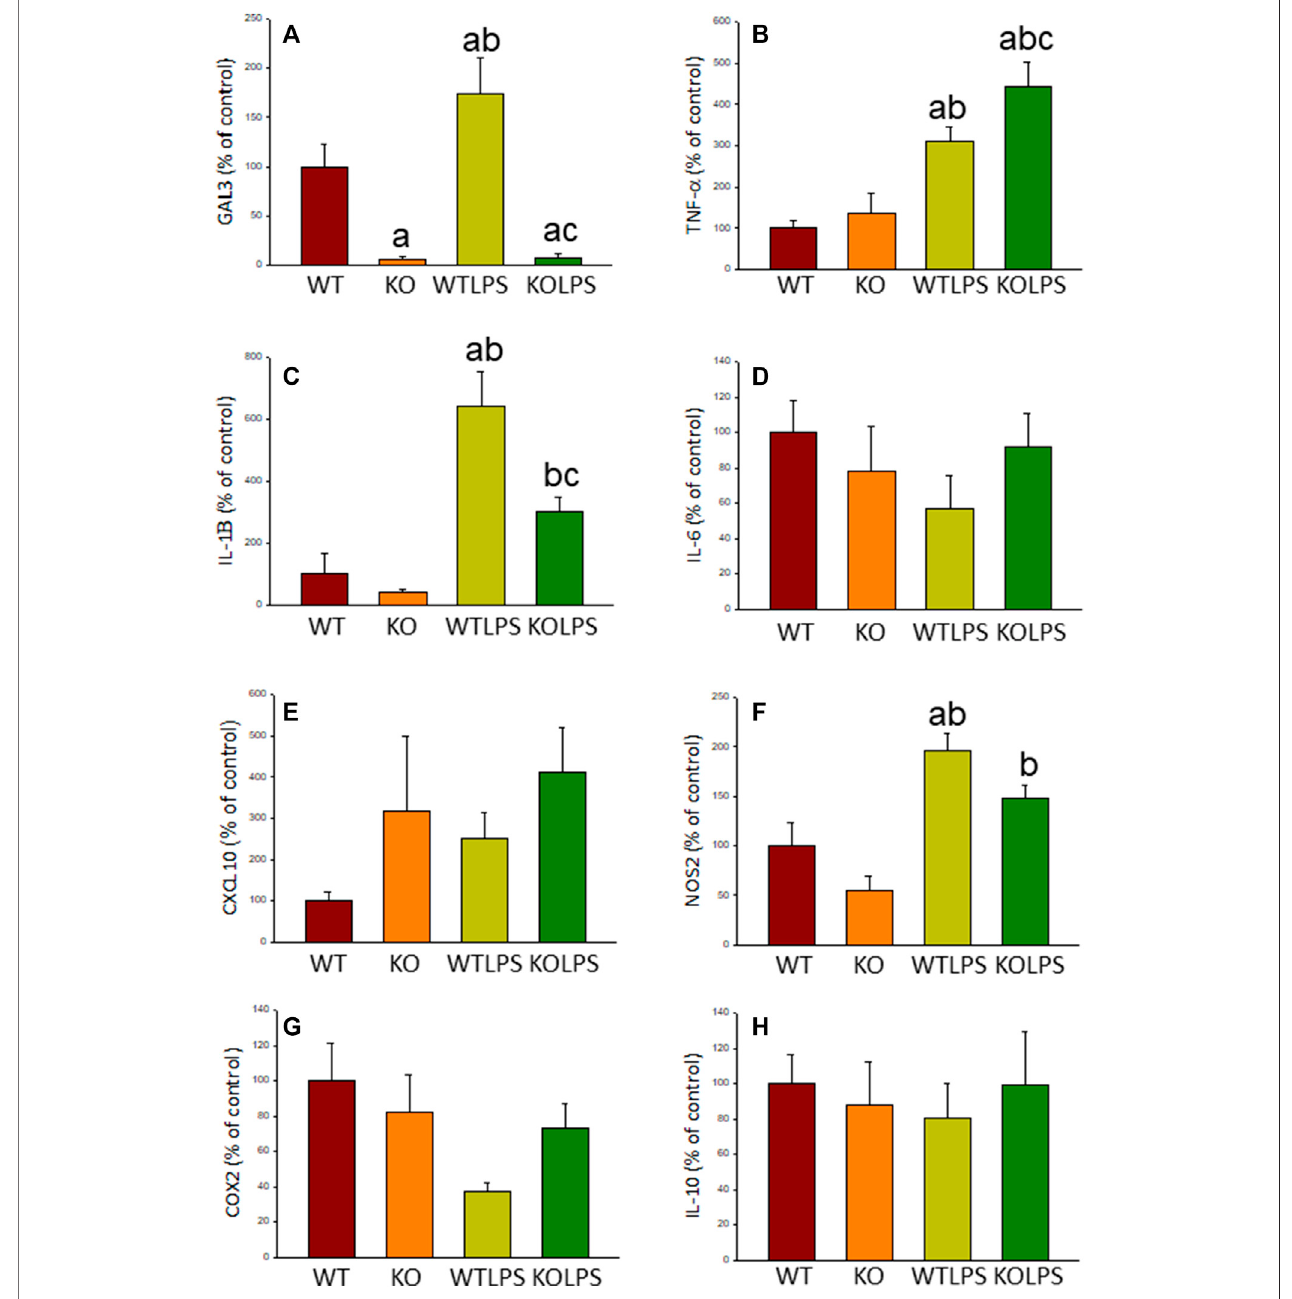
FIGURE7| EffectoftheLPStreatmentontheexpressionlevelsofGal3,TNF- α ,IL-1 β ,IL-6,CXCL10,NOS2,COX2andIL-10instriatum.Measurementoftheeffect of the treatment with LPS on the expression levels of mRNA of Gal3 (A) , pro-in fl ammatory mediators such as TNF- α (B) , IL-1 β (C) , IL-6 (D) , CXCL10 (E) , NOS2 (F) , COX2 (G) and the anti-in fl ammatory mediator IL-10 (H) in the striatum of mice from the different experimental groups by using RT-qPCR. Results are mean ± SD of at least three mice per experimental group, normalized to β -actin and expressed as percentage relative to the WT group. Statistical signi fi cance: One-way ANOVA followed by the Fisher ’ s LSD post hoc test for multiple comparisons was used, with α (cid:2) 0.05: (a) , compared with the WT group; (b) , compared with the KO group; (c) , compared with the WTLPS group; p < 0.001. Abbreviations: WT, wild type mice; WTLPS, wild type mice treated with LPS; KO, Gal3 knockout mice; KOLPS, Gal3 knockout mice treated with